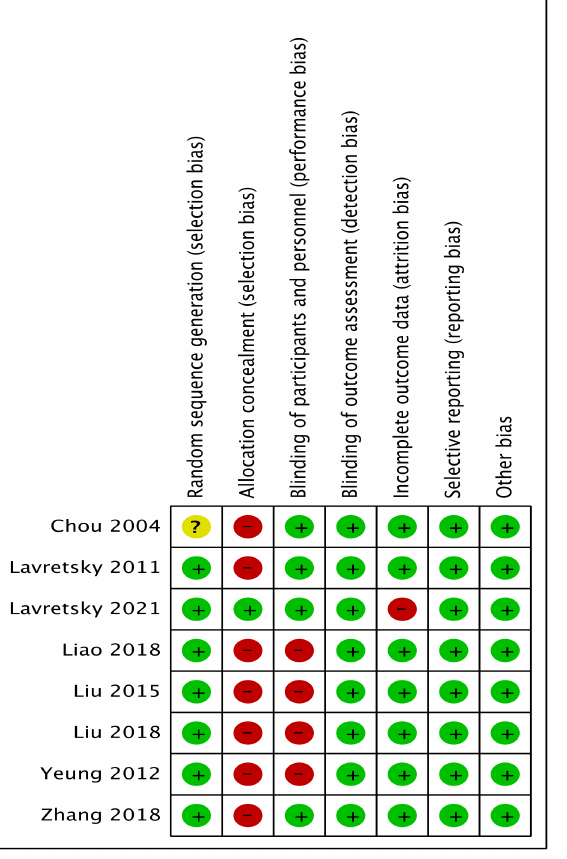
Figure 3. Risk of bias summary, showing the review authors’ judgements of each risk of bias item for each included trial [44–51]. Note: indicates low risk of bias, indicates high risk of bias and indicates unclear risk of